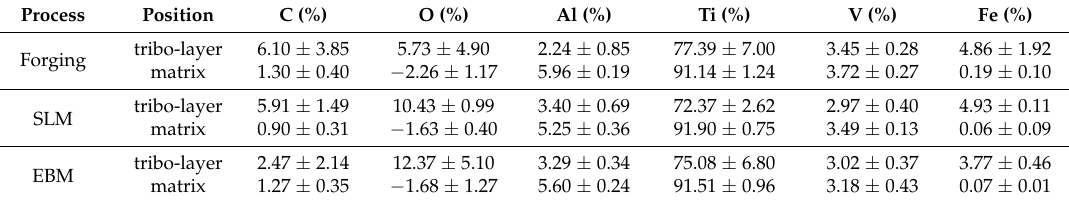
Figure 7. SEM images of wear tracks after the sliding wear tests for the Ti-6Al-4V samples: ( a – c ) forged, ( d – f ) SLM and ( g – i ) EBM. ( d – f ) SLM and ( g – i ) EBM. Table 1. Element analysis (wt. %) of the tribo-layer and matrix of the samples produced by forging, SLM and EBM